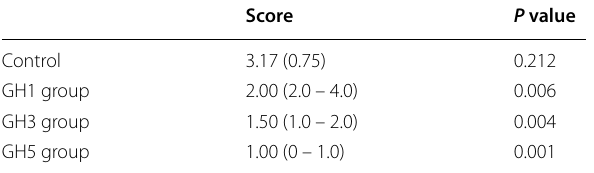
Table 2 Yoshimi score